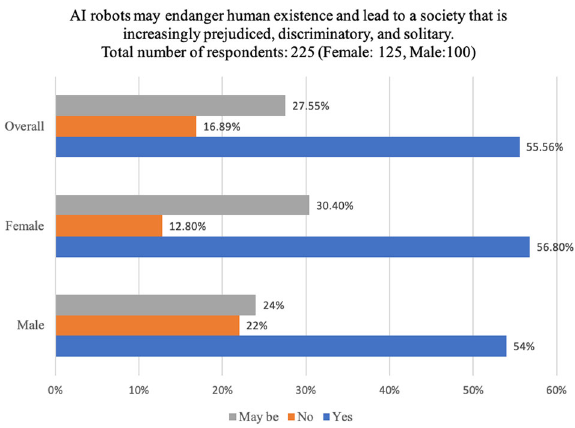
Fig. 4 Living with AI robots will become a reality in the near future. Total number of respondents:225 (Female: 125, Male: 100).